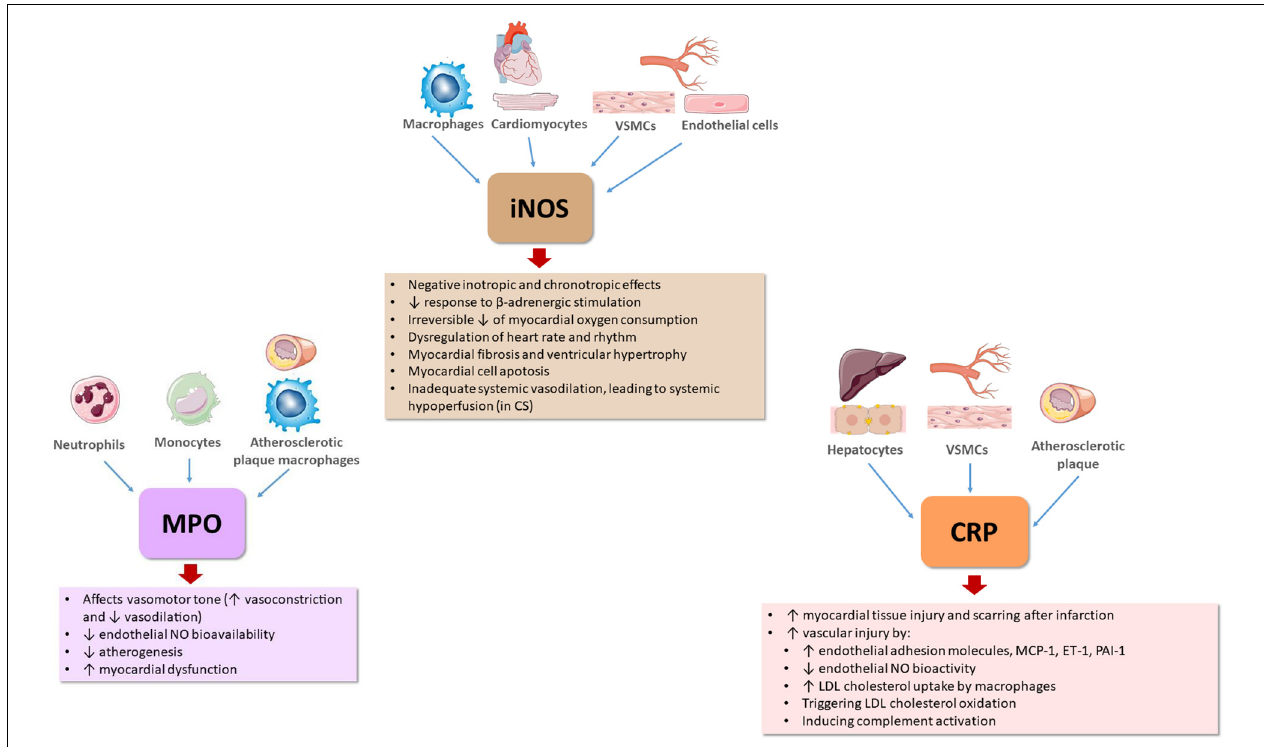
FIGURE 2 | Effects of other important inflammatory mediators contributing to heart failure pathophysiology. CRP, C-reactive protein; CS, cardiogenic shock; ET-1, endothelin-1; iNOS, inducible nitric oxide synthase; LDL, low density lipoprotein; MCP-1, monocyte chemoattractant protein-1; MPO, myeloperoxidase; NO, nitric oxide; NOS, nitric oxide synthase; PAI-1, plasminogen activator inhibitor 1; VSMCs, vascular smooth muscle